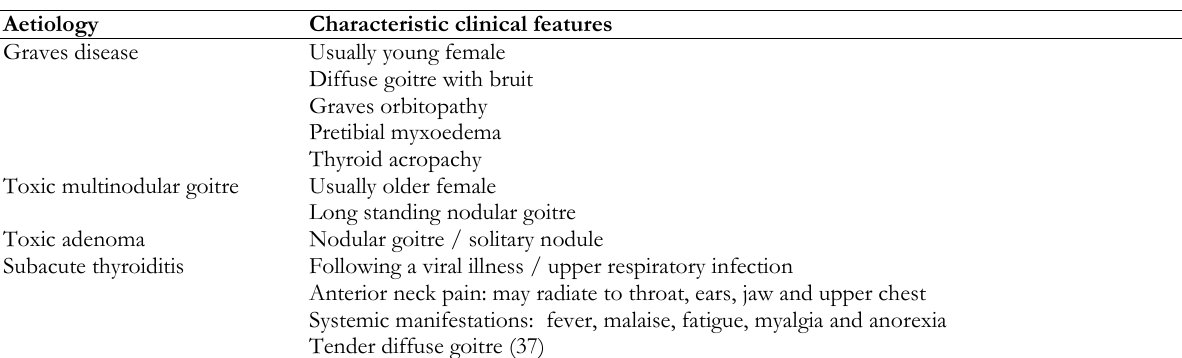
Table 3.4. Characteristic clinical features favouring an aetiology in patients with thyrotoxicosis